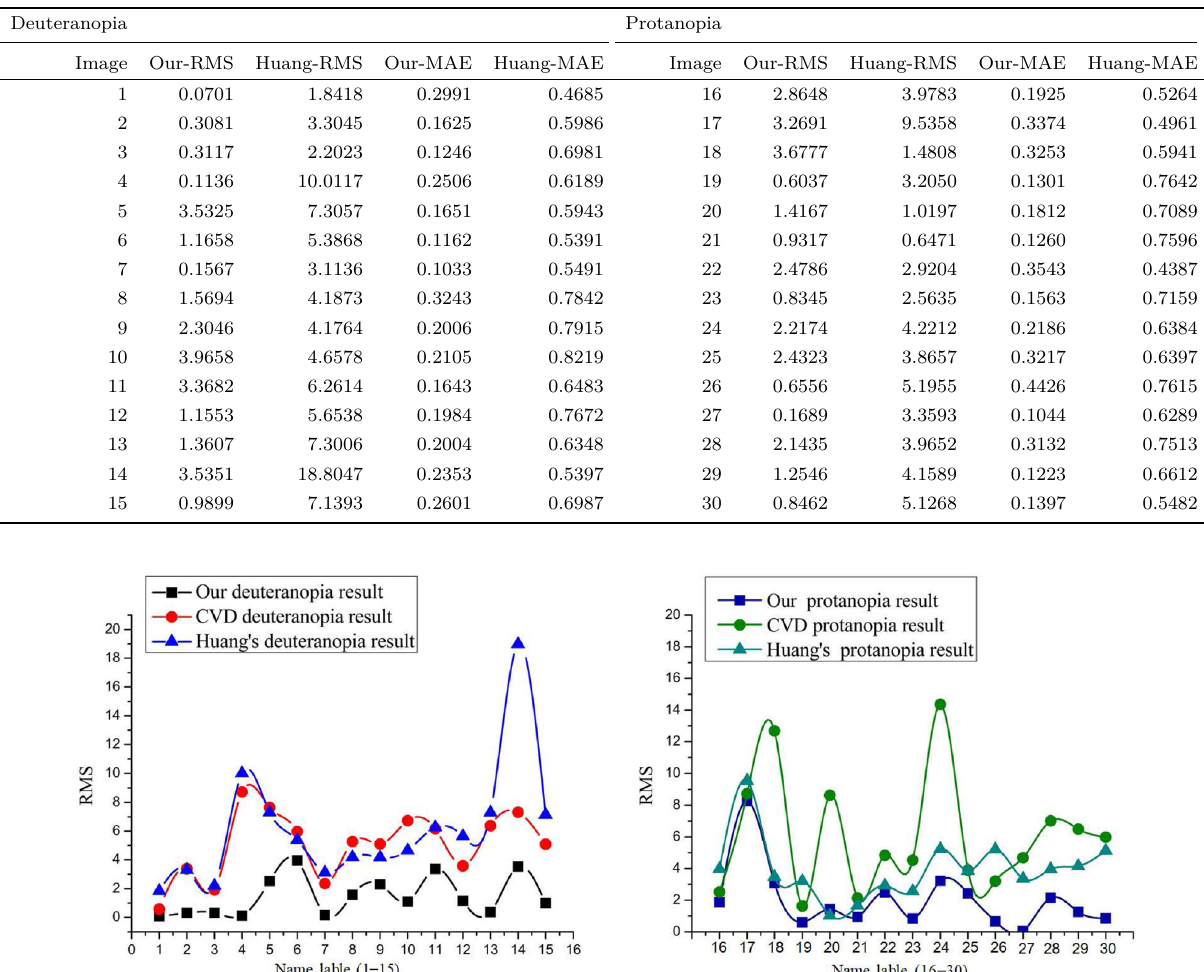
Table 2 Comparison of RMS and MAE of our method and Huang’s algorithm on different images